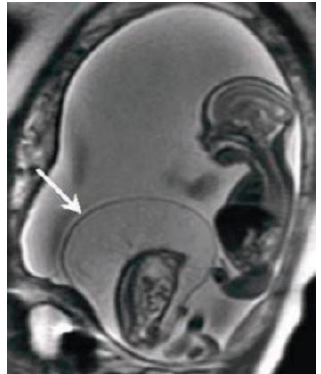
Figure 1. Fetal magnetic resonance imaging (MRI) of Twin reversed arterial perfusion (TRAP) sequence. Half-Fourier Acquisition Single-Shot Turbo-Spin-Echo (HASTE) T2 Sag. Both the acardiac (signaled by the arrow) and pump twins are visible.